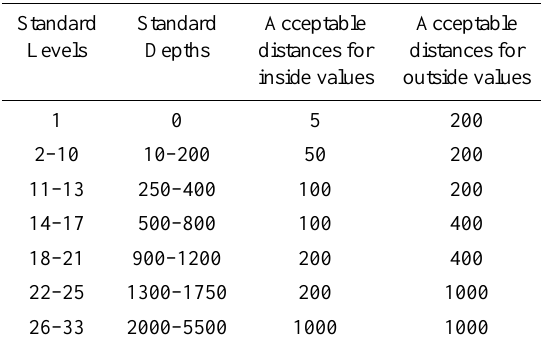
Table 1. Acceptable distances for “inside” and “outside” values used in the Reiniger-Ross scheme for interpolating observed level data to standard levels Standard Standard Acceptable Acceptable Levels